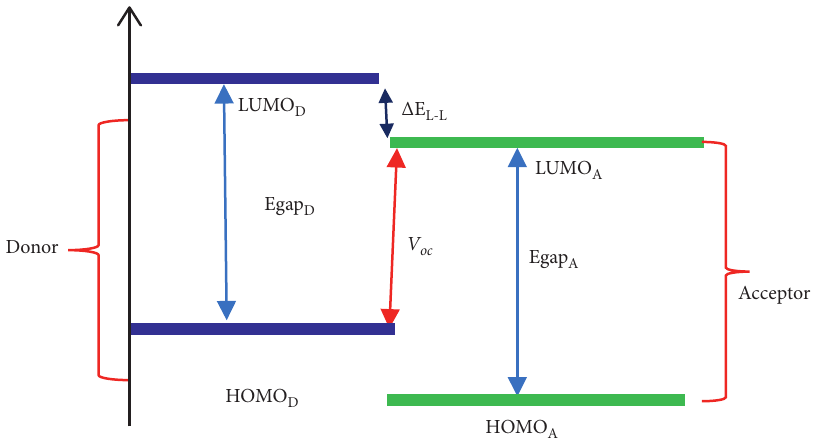
Figure 2: Energy level diagram for a donor-acceptor in organic solar